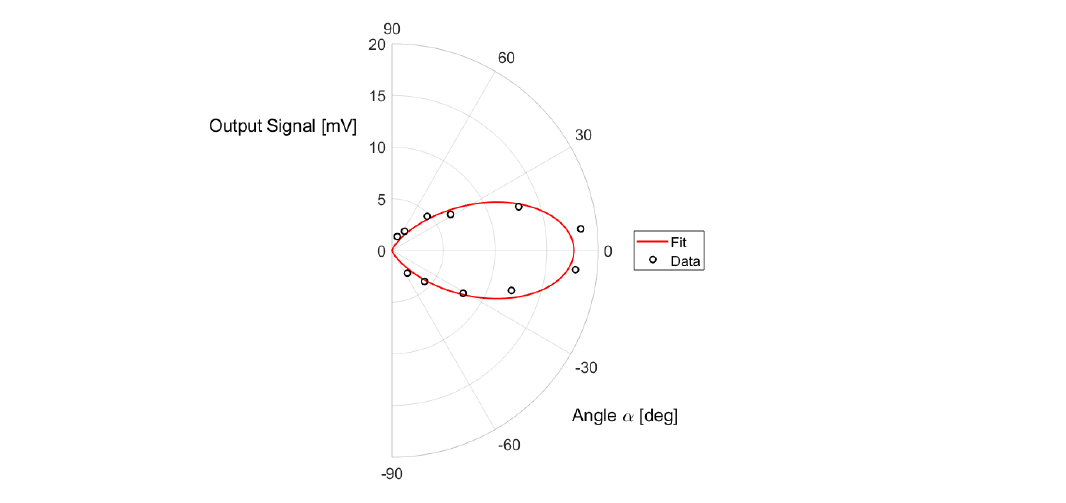
Figure 15. Graphical comparison between the derived fit and the measured data in the case of 1-m fixed